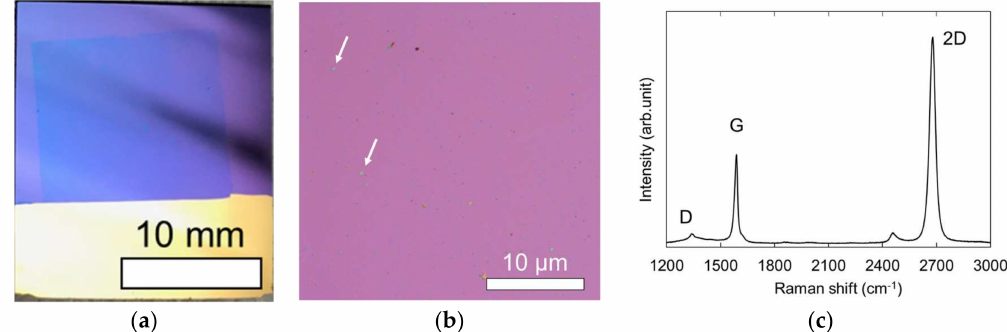
Figure 4. Characterization of the chemical vapor deposition (CVD)-grown graphene film on SiO 2 / Si substrate. ( a ) Optical image after deposition of the Au / Ni (50 nm / 10 nm). ( b ) Optical micrograph. Arrows indicate poly-methyl methacrylate (PMMA) residues. ( c ) Raman